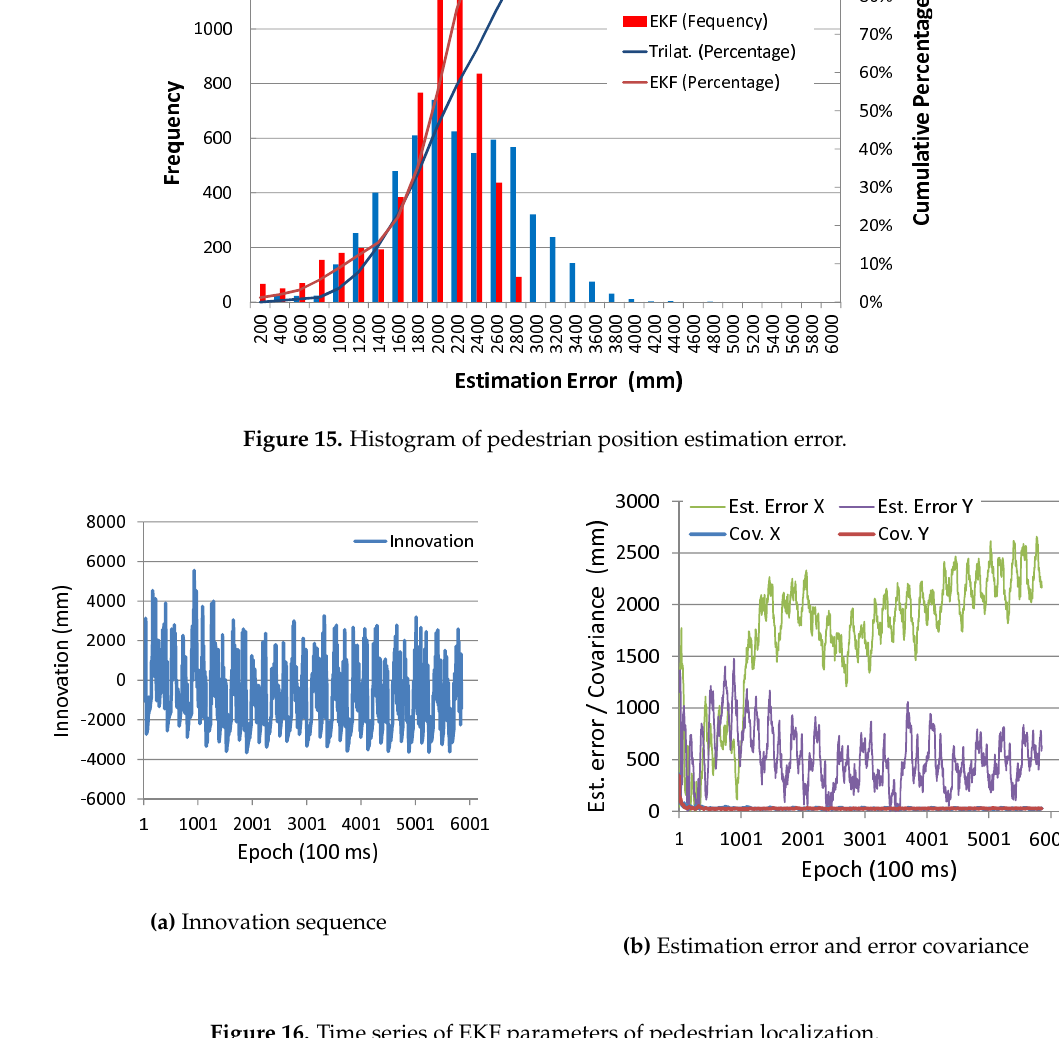
Figure 16. Time series of EKF parameters of pedestrian